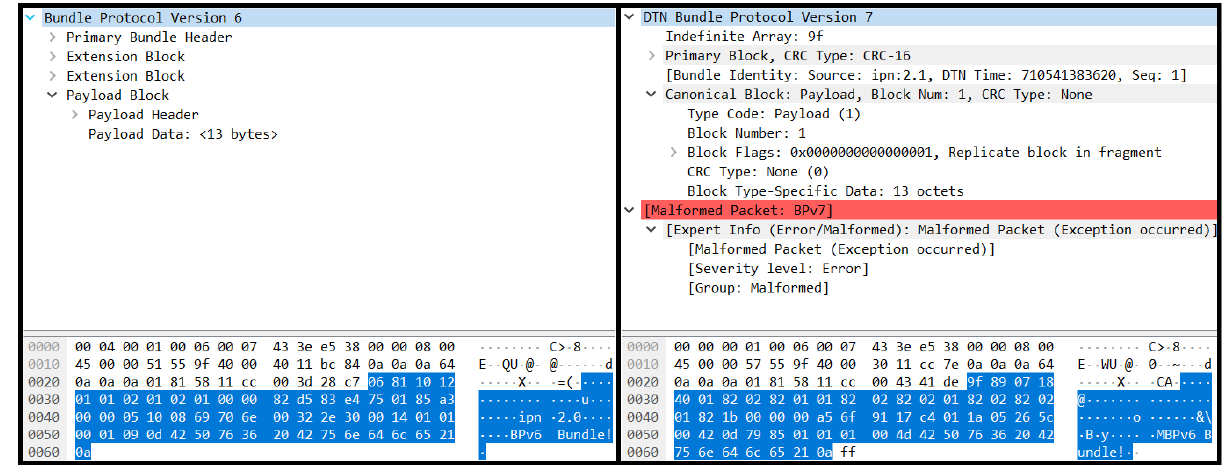
Figure 11. Translation of BPv6 to BPv7. The bundle layer bytes are highlighted in blue.